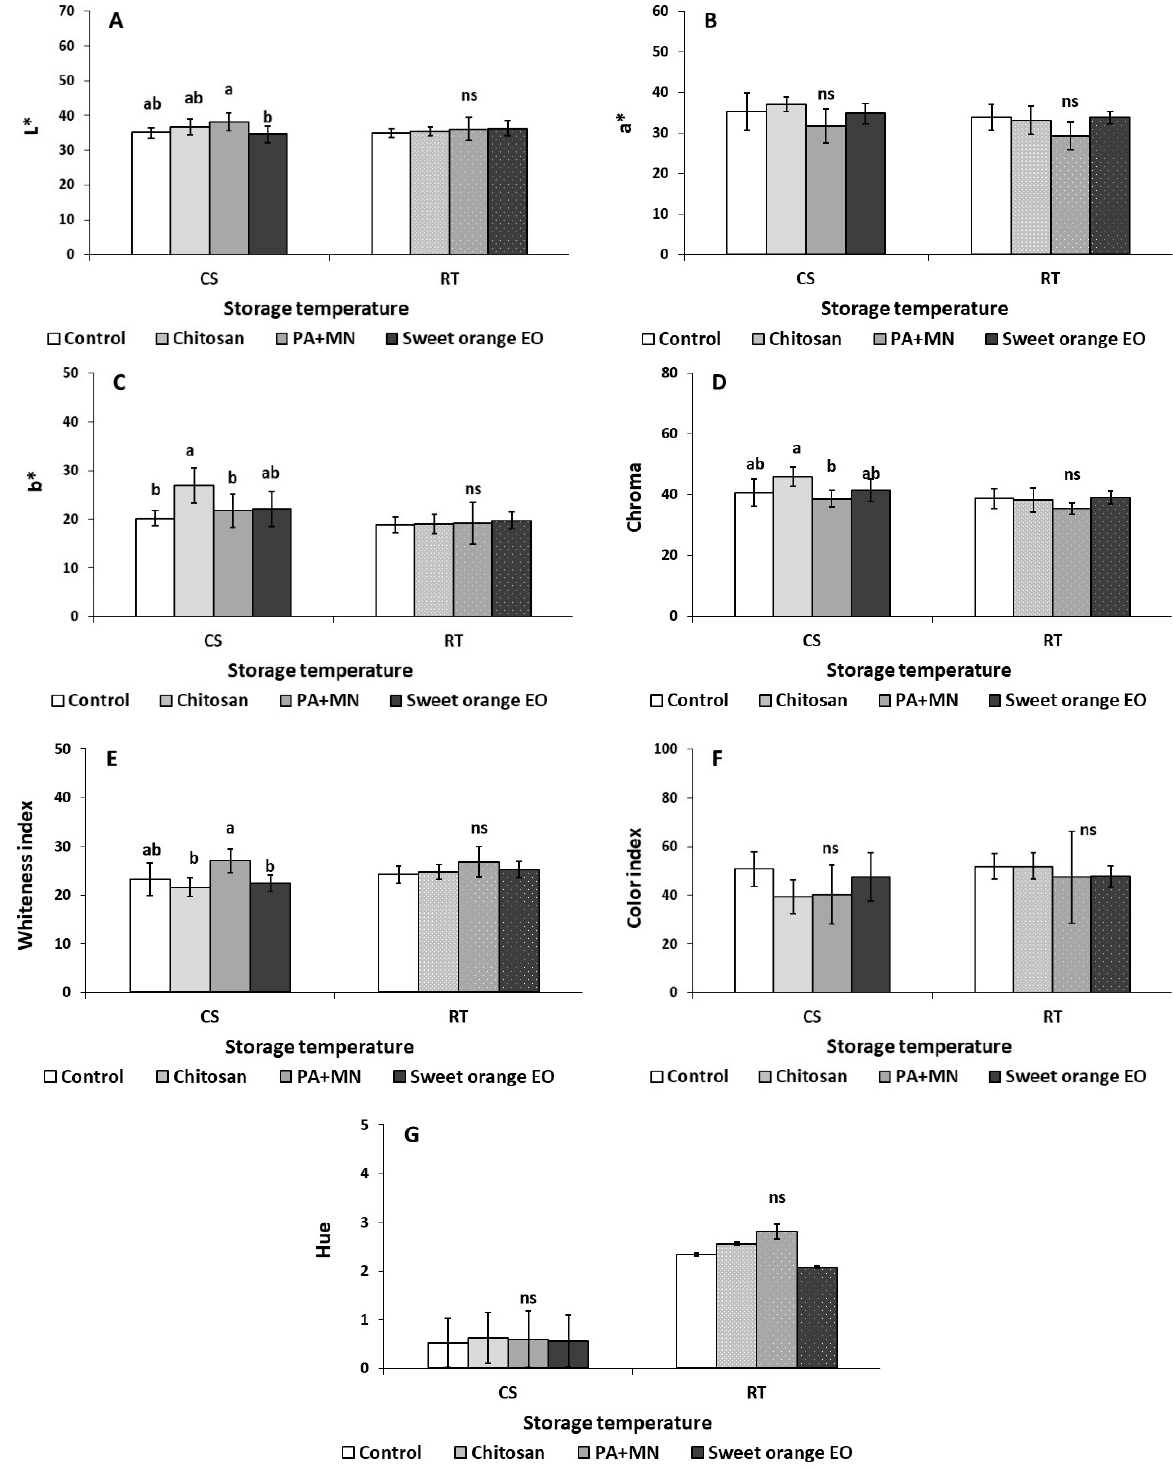
Figure 2. Effect of chitosan, phosphoric acid plus micronutrients (PA+MN), and sweet orange EO treatment and three days of storage at RT (20 °C) and CS (4 °C) on strawberry color parameters: ( A ) L* color, ( B ) a* color, ( C ) b* color, ( D ) Chroma value, ( E ) Whiteness index, ( F ) Color index, and ( G ) Hue angle. Error bars represent the standard deviation of the mean of three/six replicates. Treatments indicated with different letters for each storage condition differed significantly (Tukey’s honestly significant difference, at p ≤ 0.05); ns: not significant.